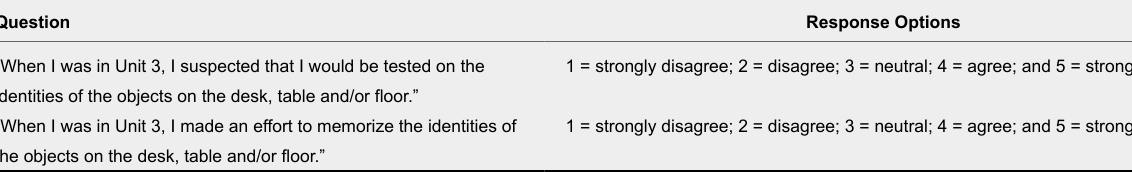
Questions Used to Classify Anticipation of the Memory Task (Experiment 3) Question Response